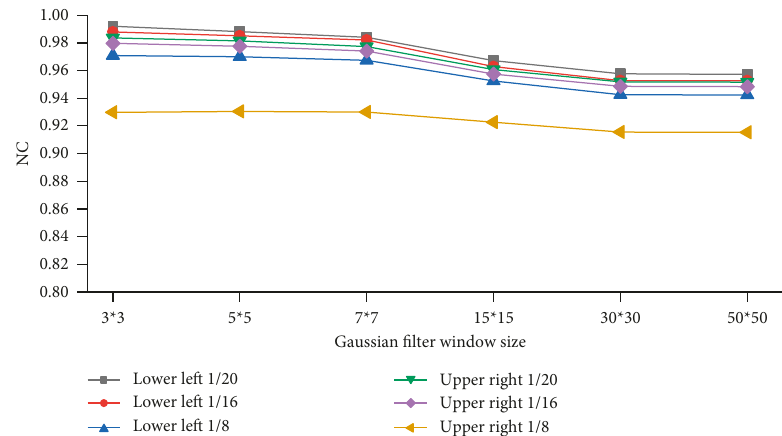
Figure 15: NC mean under combined attack of shear and Gaussian filter.